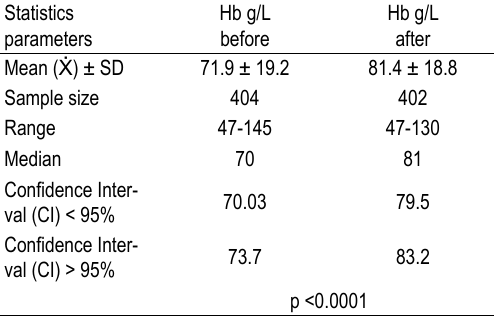
Table 3. changes of Hemoglobin before and after transfu- sion treatment in patients with Gastro intestinal